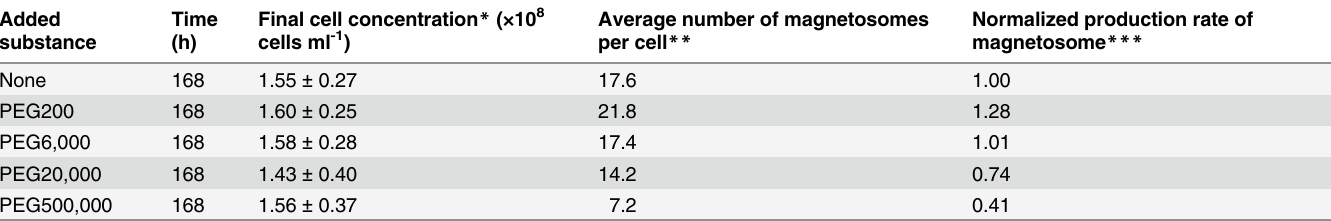
Table 1. Effect of PEGs on the growth of M . magnetotacticum MS-1 and the formation of